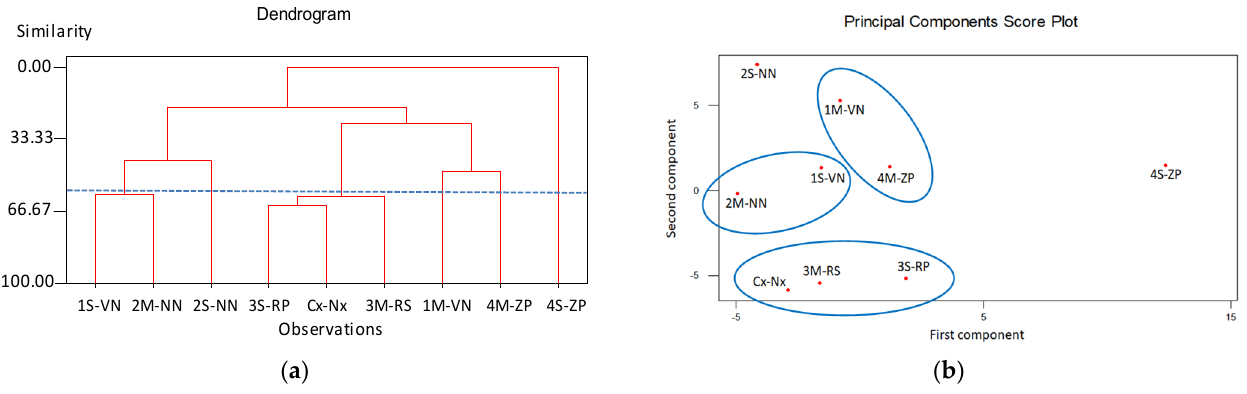
Figure 5. Principal Component Analysis (PCA) and cluster analysis from 1 H NMR data applied to score plots for all the samples : ( a ) Agglomerative Hierarchical Clustering (AHC) dendrogram for the correlation of variables; ( b ) results for 60% of similarity.